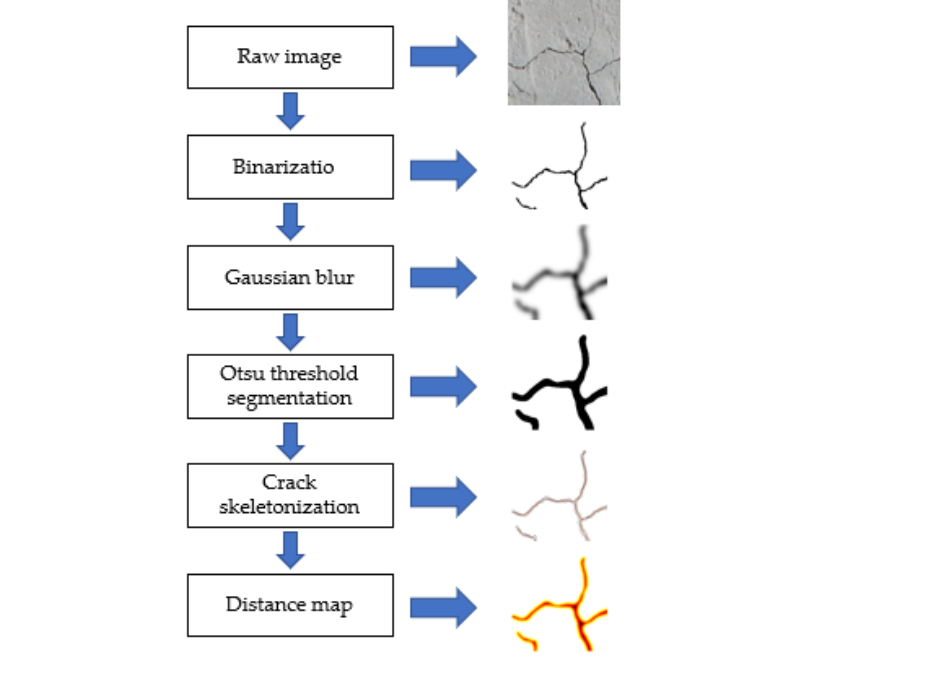
Figure 5. The process of digital image processing methods. Image binarization. The maximum inter-class variance method is used to convert